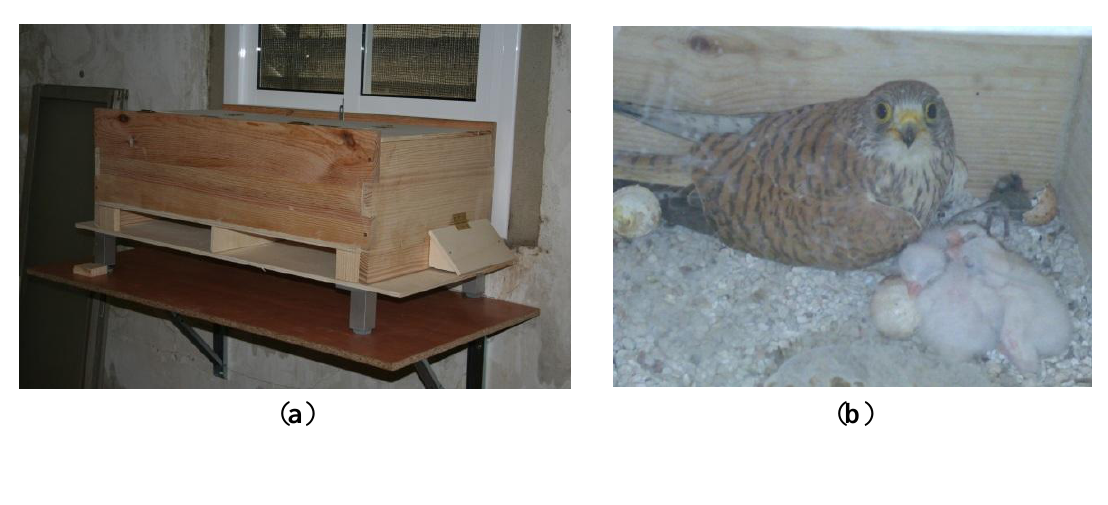
Figure 5. Smart nest boxes: ( a ) Exterior view; ( b ) Interior